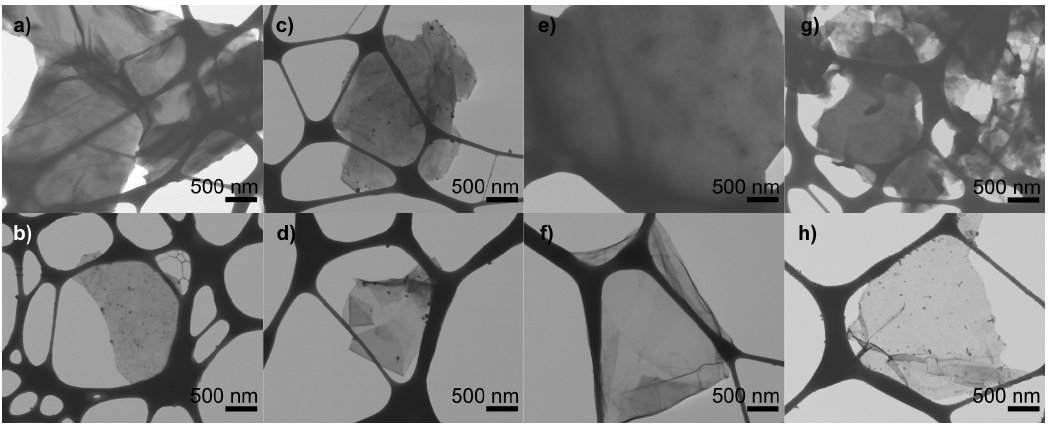
Figure 7. FESEM micrographs of the different GrO samples. ( a ) cGO, ( b ) B1, ( c ) B2, ( d ) B3, ( e ) C1, ( f ) C2, ( g ) D1, and ( h ) D2.